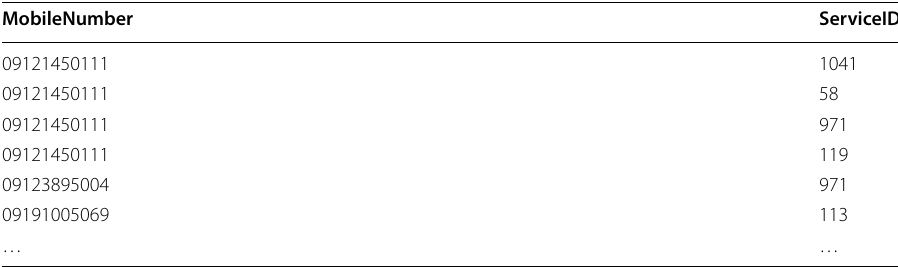
Table 19 Input data format